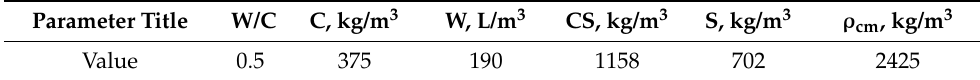
Table 9. Parameters of the composition of the concrete